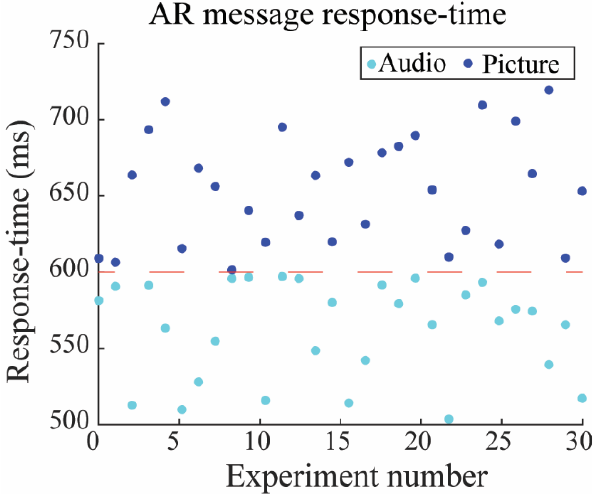
Figure 11. AR audio and picture message response time after the decision ‐ making process. An average of 553 ms is required to play a voice message, and to show a three ‐ dimensional image message, the mean value of response time is 670 ms.